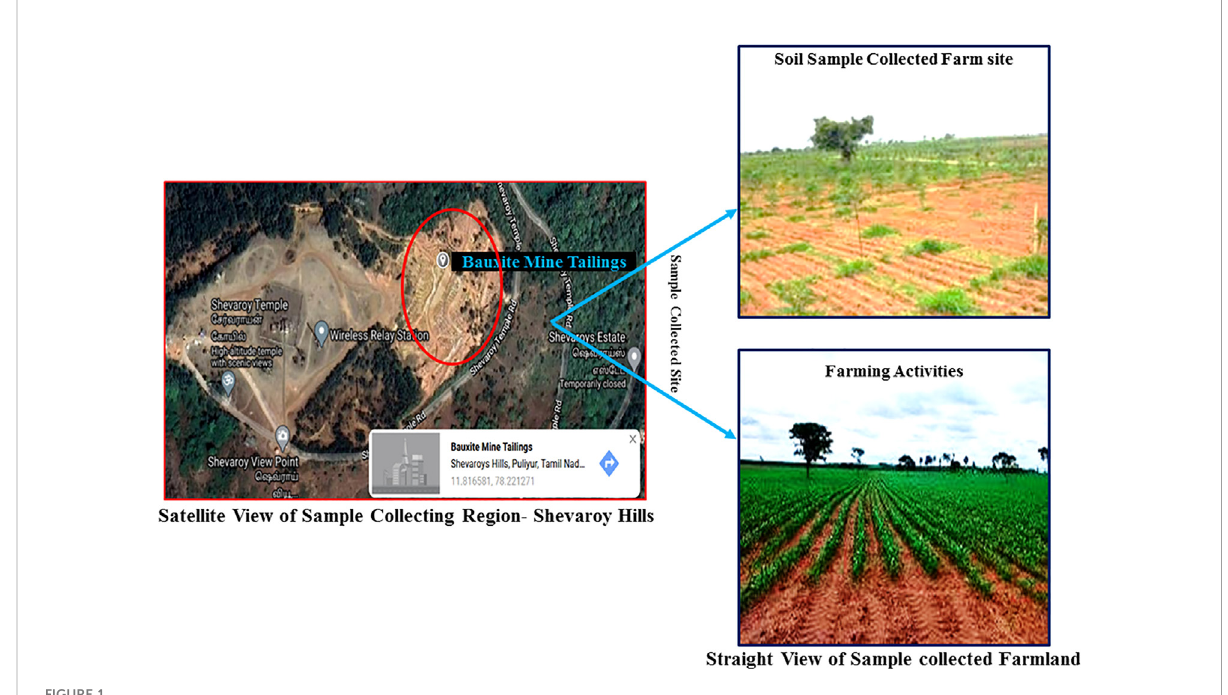
FIGURE 1 Satellite and straight view of study area. Red circle indicates heaps of abandoned bauxite mine